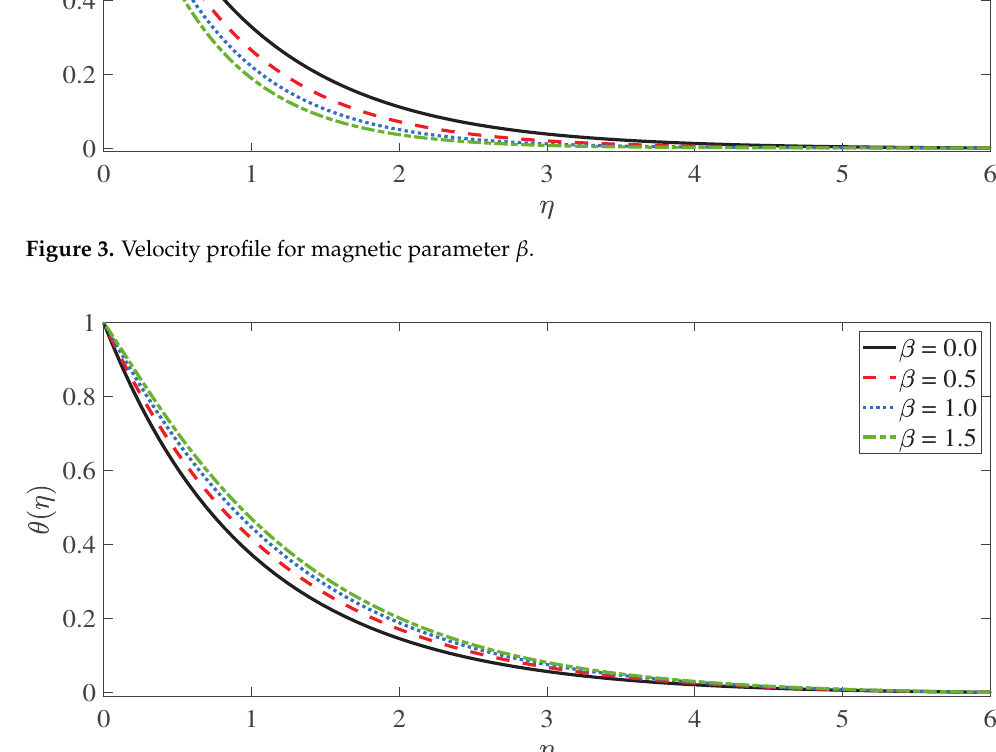
Figure 4. Temperature profile for magnetic parameter β